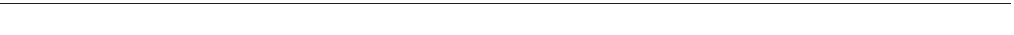
Fig. 2 SHP2 is downregulated in TGF β signaling. a , b Decreased mRNA ( n = 6) ( a ) and protein ( n = 4) ( b ) levels of SHP2 in healthy fi broblasts stimulated with TGF β (10 ng/ml) for different time points as measured by RT-PCR and western blot, respectively. c , d Overexpression of TBRI CA (6.67 × 10 7 IFUs every 2 weeks) signi fi cantly reduced mRNA ( n = 8) and the protein levels of Shp2 in murine skin as shown by qPCR ( c ) and immuno fl uorescence staining ( d ) of Shp2 with co-staining for fi broblast marker Vimentin and DAPI ( n ≥ 6 per each group). Representative images are shown at 100 – 200- and 600-fold magni fi cation. Horizontal scale bar, 500 μ m. Immuno fl uorescence pictures were analyzed by Voronoi tessellation. e , f Treatment with the selective TGF β receptor type 1 kinase inhibitor SD208 (60 mg/kg/day) reversed the decrease of Shp2 mRNA ( n = 6) ( e ) and protein ( n = 4) ( f ) in bleomycin-challenged mice (50 µ g every other day). g , h Treatment with the selective TGF β receptor type 1 kinase inhibitor SD-208 reversed the decrease of Shp2 mRNA ( n = 6) ( g ) and protein ( h ) in TSK1 mice (2 mg tamoxifen over 5 days) ( n ≥ 6 per each group). i Phosphatase activity assay. Increases in SHP2 activity after TGF β stimulation (10 ng/ml) ( n = 4) in cultured fi broblasts and upon overexpression of TGF β RI (6.67 × 10 7 IFUs) in murine skin ( n ≥ 4 per each group). Results shown are representative of three independent experiments. All data are presented as median± s.e.m. The p values are expressed as follows: 0.05 > p > 0.01*; 0.01 > p > 0.001**; p < 0.001***. Signi fi cance was determined by Mann – Whitney test. AdLacZ: adenovirus LacZ, TBRI CA : constitutively active TGF β receptor type I, TSK1: Tight skin, Bleo: bleomycin, Pa/Pa: control for TSK1, fl uo.: fl uorescence, int.: intensity, Unst.: